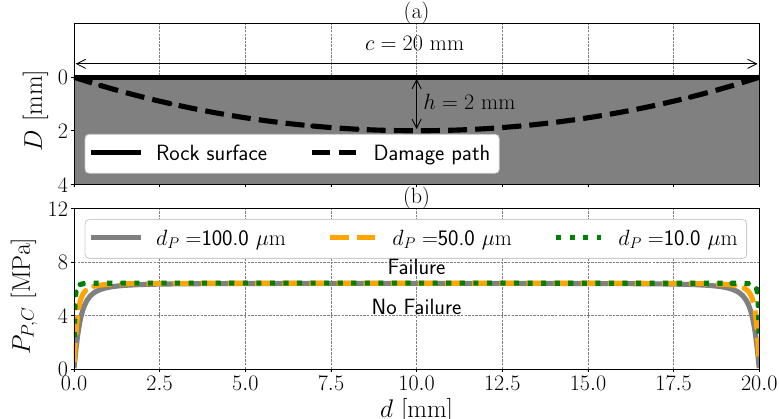
Figure 5. ( a ) The profile of the fracture depth, D , and ( b ) the critical pore pressure, P P , C , (i.e., the rock failure criterion) as a function of the distance from the left electrode, d , for the three investigated pore sizes, d P